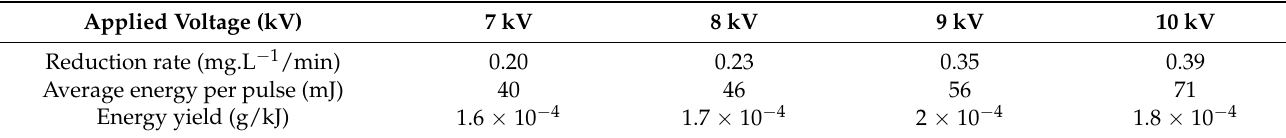
Table 2. Influence of applied voltage on Cr(VI) reduction efficiency and the discharge characteristics. Cr(VI) solution (47 mg/L, σ = 4 mS/cm, pH = 2.3), V = 100 mL, ∆ t = 500 µ s, gap = 5 mm, electrode length = 0 ± 10 µ m, f = 50